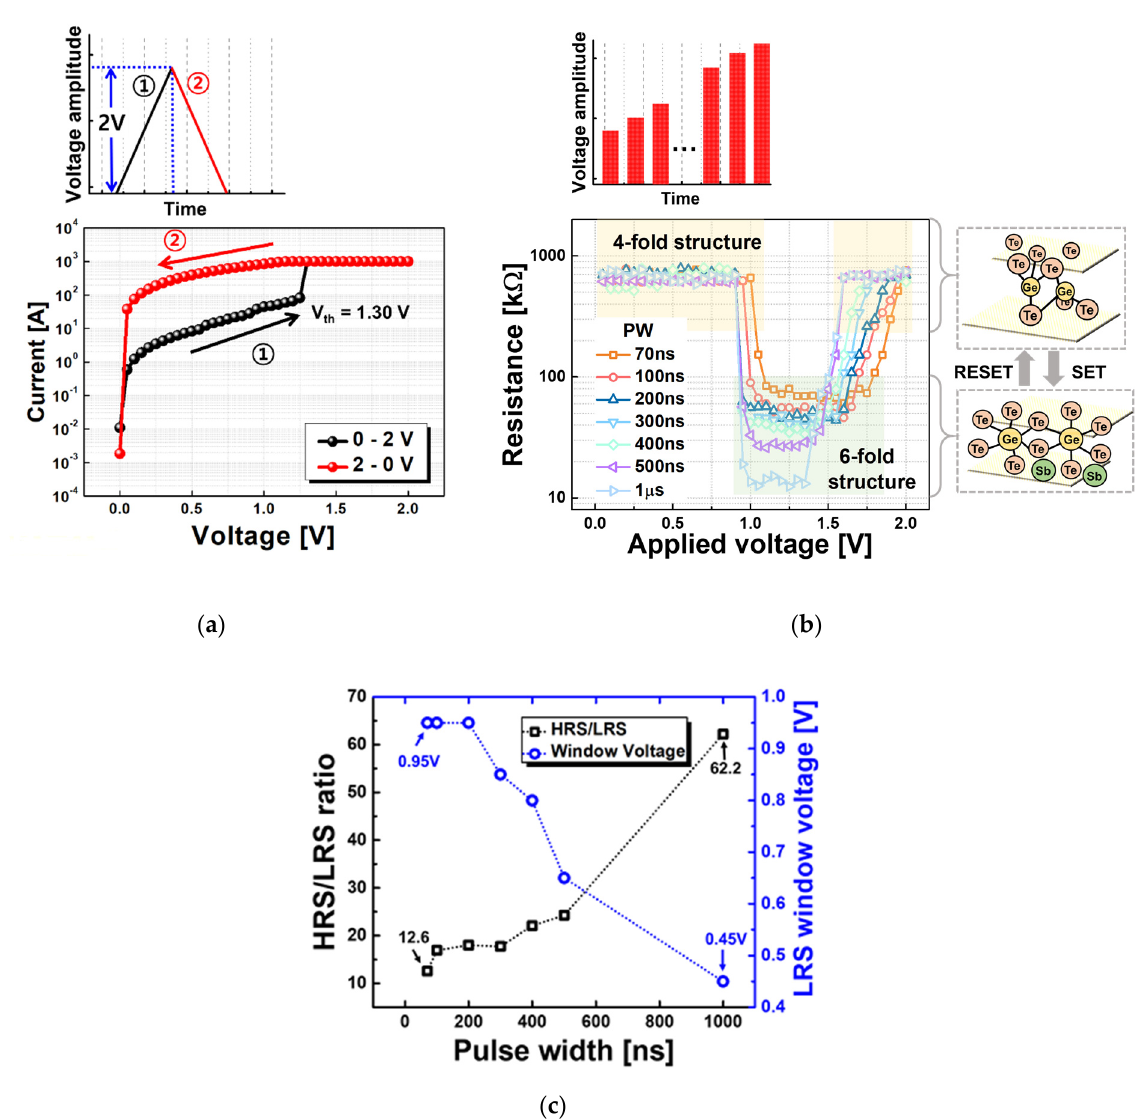
Figure 2. ( a ) The (GeTe/Sb 2 Te 3 ) 16 iPCM switching characteristics of DC mode ( b ) The reversible resistance switching of the resistance-voltage (R-V) characteristics of the (GeTe/Sb 2 Te 3 ) 16 iPCM devices for different pulse widths and a schematic of a simplified transition model of the iPCM. ( c ) The HRS/LRS ratio (black) and LRS window voltage (blue) as a function of the applied pulse width.